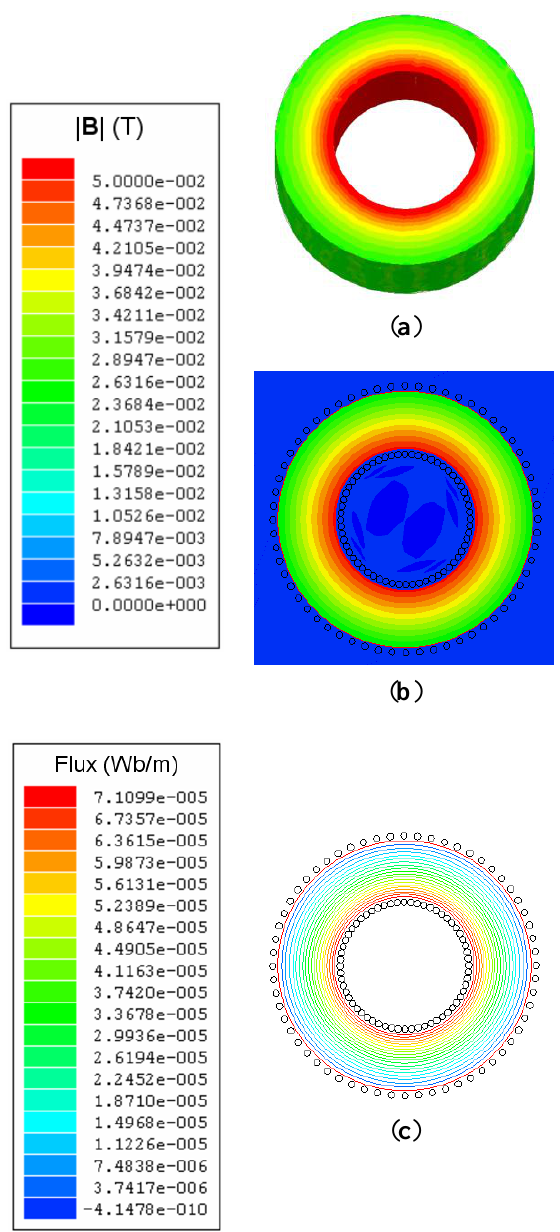
Figure 5. Geometry of the 60-turn inductor used for the 3D simulations with the TN23/14/7 ferrite core with right angled